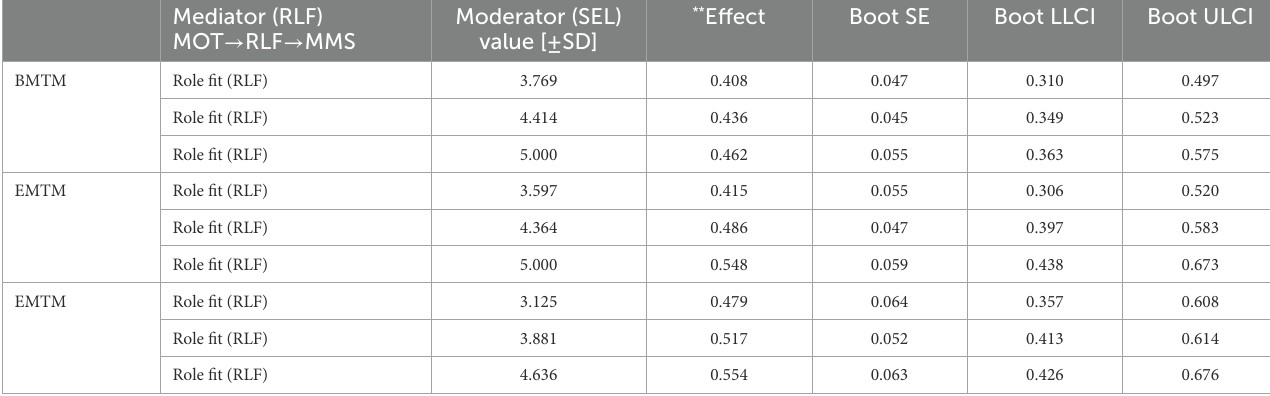
TABLE 7 The conditional indirect effects through role fit (RLF) evaluated by using the PROCESS v3.5 macro-Model 59. Mediator (RLF) MOT → RLF →